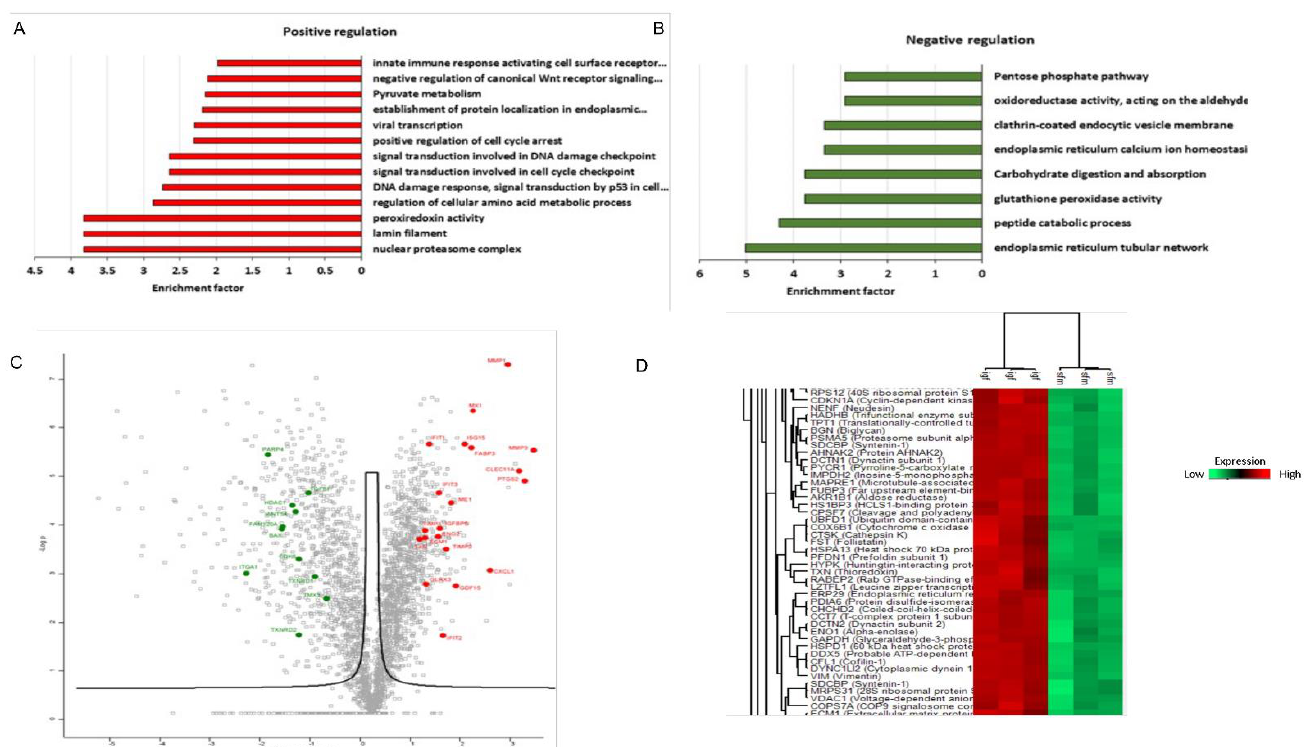
Figure 6. Signature of core senescence proteins, networks and pathways in prolonged IGF1-induced senescence. Summary of proteins significantly altered ( p -value < 0.05) by prolonged IGF1 treatment compared to serum starvation condition in human skin primary fibroblasts. Analyses were performed with the Perseus tool using proteins with FDR-corrected p -value less than 0.05 and log 2 fold-changes greater than 1.5. ( A , B ) Gene Ontology enrichment analysis of differentially expressed proteins in prolonged IGF1-treated cells. Proteins were ranked by average log 2 fold-change and analyzed by gene set enrichment analysis (GSEA). Normalized enrichment score was calculated for upregulated and downregulated pathways resulting from prolonged IGF1 treatment. ( C ) Volcano plot representing average log 2 (prolonged IGF1 treatment — serum starvation) fold-change in X -axis versus – log 10 p -value in Y -axis, combined statistical significance from three datasets. Red and green dots denote proteins that were consistently up- or downregulated, respectively, in all three datasets (FDR-corrected p -value < 0.05, average absolute log 2 fold-change > 1.5). ( D ) Hierarchical clustering representing a part of the cluster containing differentially expressed proteins with the smallest FDR-corrected p -value after integrating the three datasets. All independent technical replicates are shown. Note that the fold-changes presented in the figure are in logarithmic terms (log 2 ). Log 2 fold-change of 1.5 is equal to fold-change of 2 or (1.5) 2